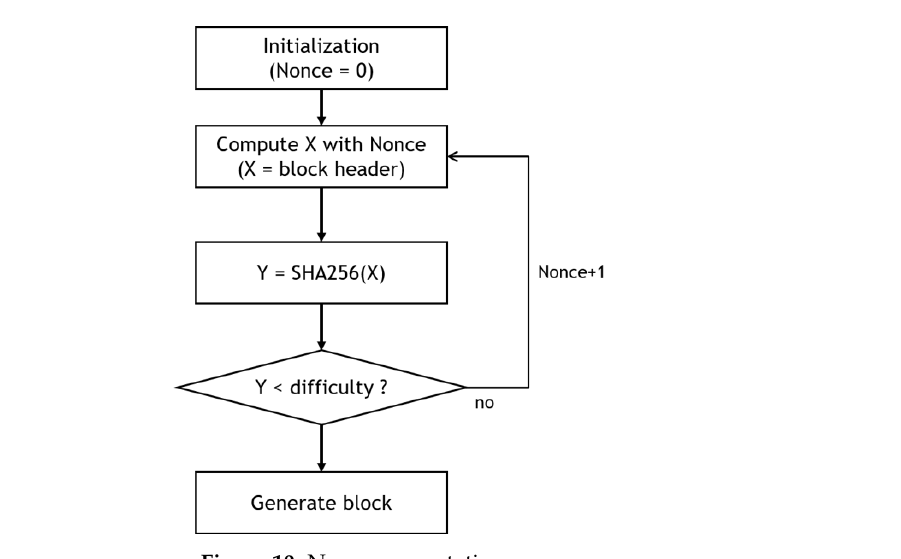
Figure 10. Nonce computation